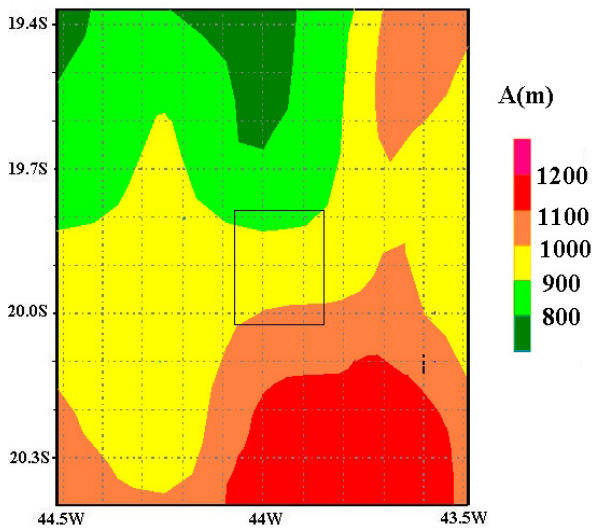
Fig. 5. Eight-year (1989–1996) mean negative peak current in kA centered on Belo Horizonte (indicated by a black rectangle), at a spatial resolution of 9km.